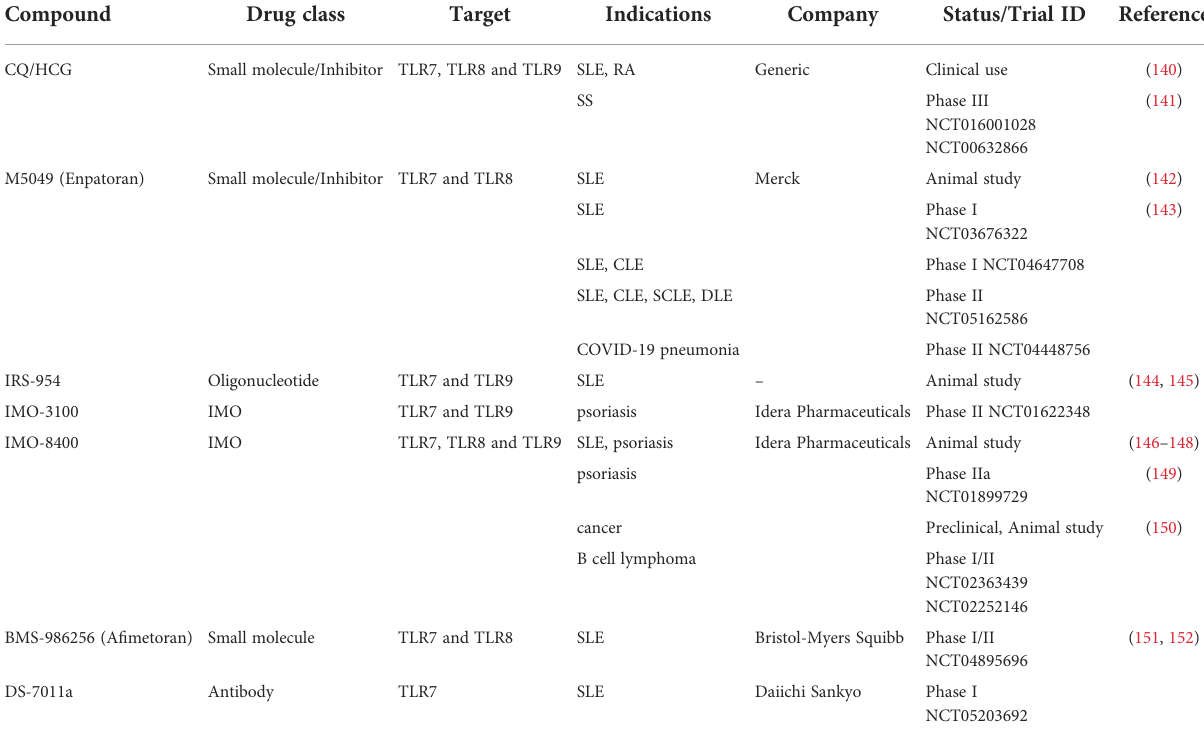
TABLE 1 Compounds in development that target human nucleic acid-sensing TLRs for autoimmunity.